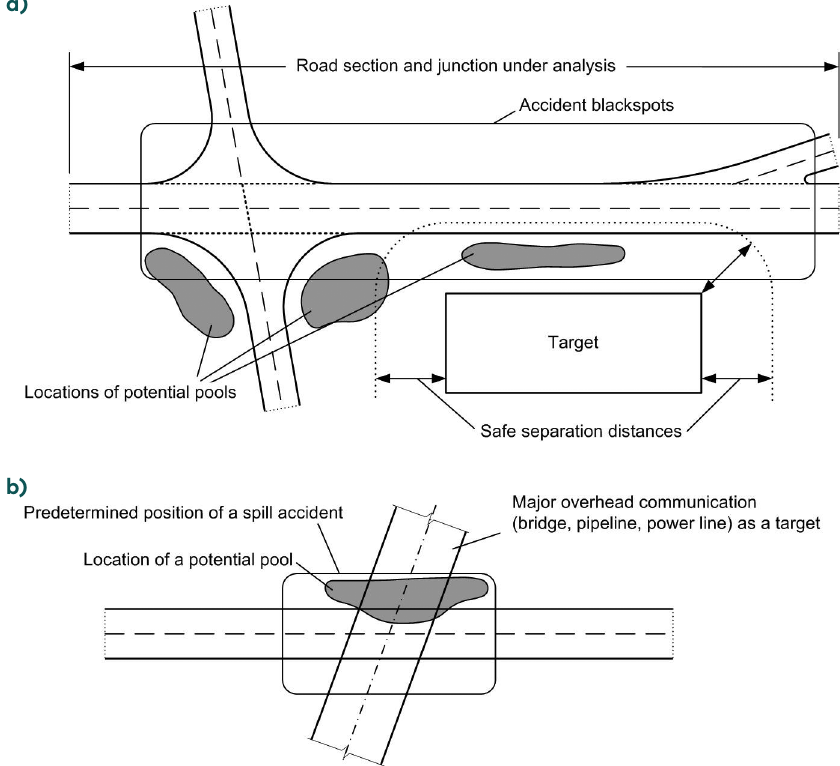
Figure 4. Two locations of the road network where pool fire accidents should be considered: a) road section and junction with increased concentration of traffic accidents, b) predetermined